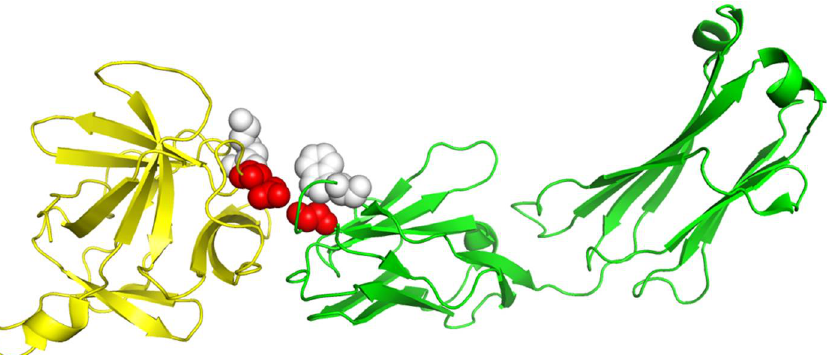
Figure 2. The ROC curves for RRI predictors based on LOOCV. Figure 3. The 3D structure illustration for protein complex 4G6M. Its A chain and L chain are colored in yellow and green, respectively. The red balls indicate the true residue interacting sites, for which RRI-Meta predicted correctly, whereas the predictions of the competing tool, PAIRpred, were incorrect. The gray balls mark the part without residue interactions. RRI-Meta classified it as noninteracting correctly; however, PAIRpred misclassified it to be interacting.